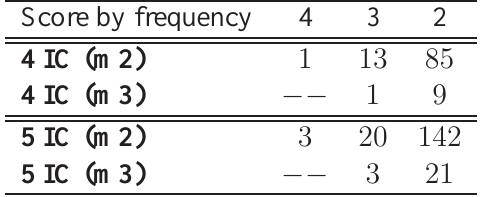
Table 6: Score by frequency: differentially expressed genes in 4,3,2 components, from m2 and m3 intervals. The numbers indicate the size of the gene